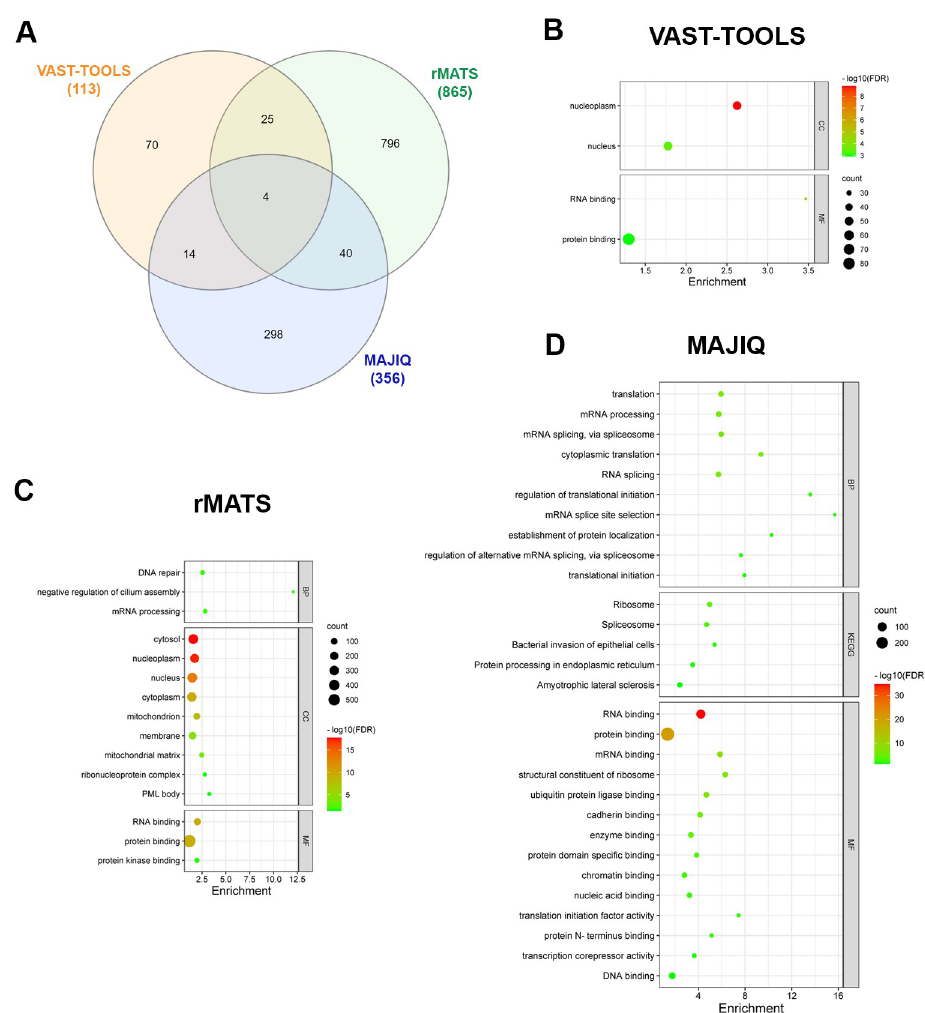
Fig 4. Analysis of alternative splicing events predicted to be altered by ethanol in the human embryoid bodies differentiation dataset. A) Venn diagram showing the number of genes predicted to contain alternative splicing events altered by ethanol using VAST-TOOLS, rMATS, and MAJIQ. B—D) Gene Ontology analysis of genes predicted to contain alternative splicing events altered by ethanol by VAST-TOOLS (B) , rMATS (C) , and MAJIQ (D) . BP, Biological Process, CC, Cellular Component, MF, Molecular Function, KEGG, Kyoto Encyclopedia of Genes and Genomes, FDR, False Discovery